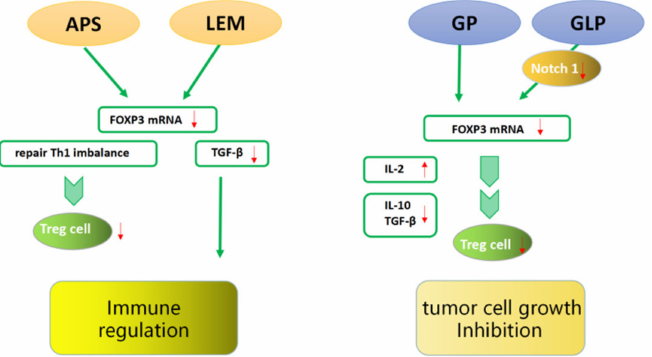
Figure 6. FOXP3 interacting with traditional Chinese medicine. TCM ingredients can improve anti- tumor immunity and inhibit tumor cell growth by reducing the number and inhibiting the function of FOXP3 + Tregs and immunosuppressive cytokines